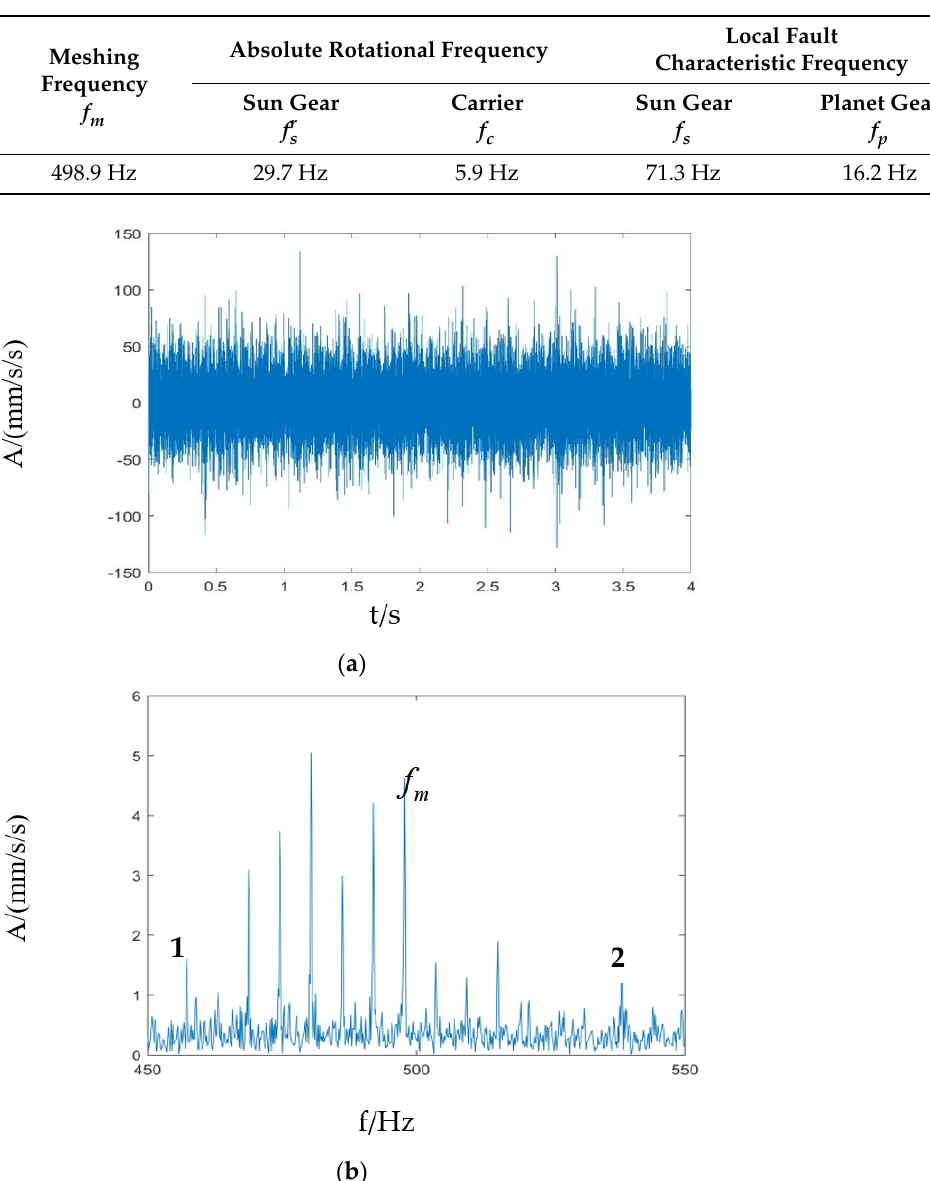
Table 4. Experiment of planetary gearbox characteristic frequency.